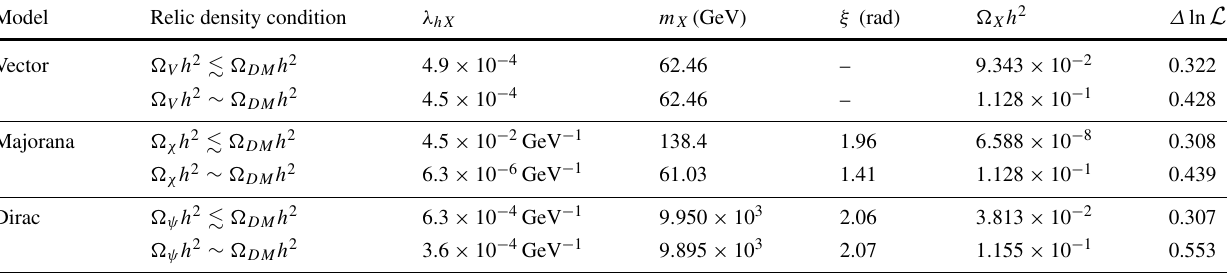
Table 7 Details of the best-fit parameter points for vector, Majorana and Dirac DM Higgs portal models, both with and without the require- ment that the predicted relic density is within 1 σ of the Planck observed value. Here, X ∈ { V ,χ,ψ } and the dimensionful nature of the coupling